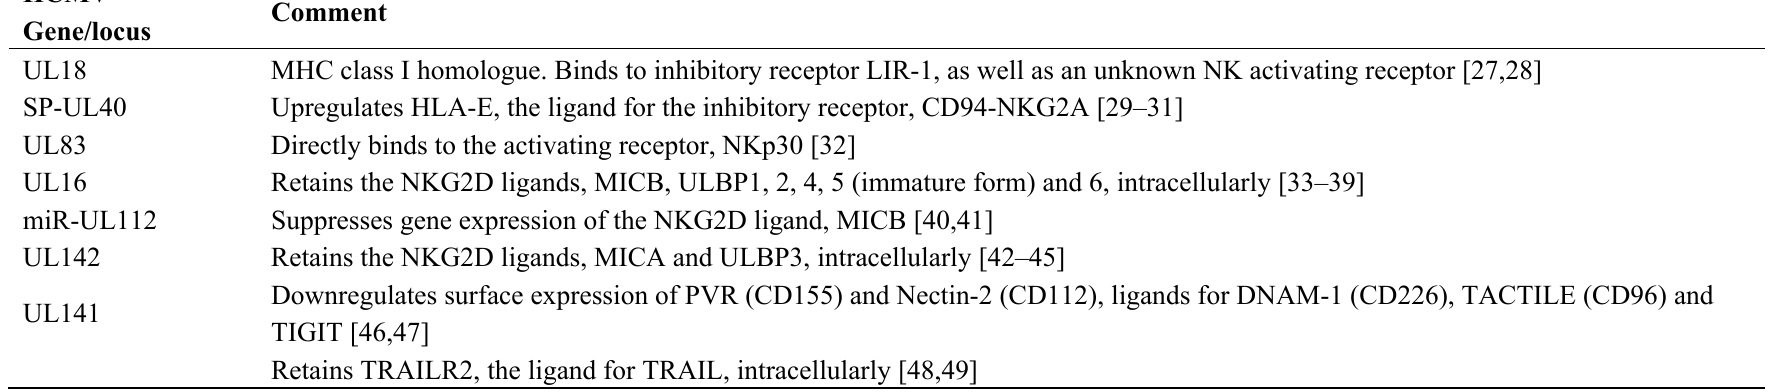
Table 1. Natural Killer (NK) immunomodulatory functions encoded by Human cytomegalovirus (HCMV). MHC, major histocompatibility complex; MICB, major histocompatibility complex (MHC) class I chain related protein B; ULBP, UL16 binding protein; PVR, poliiovirus receptor; TRAILR, tumour necrosis factor-related apoptosis inducing ligand